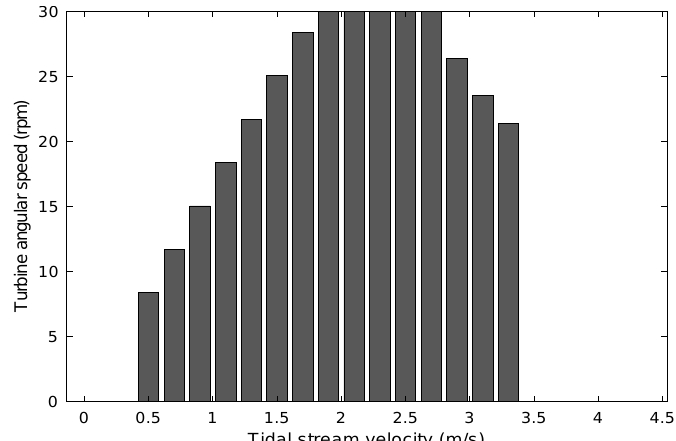
Figure 9. Speed curve of the fixed pitch tidal turbine as a function of the tidal stream velocity.